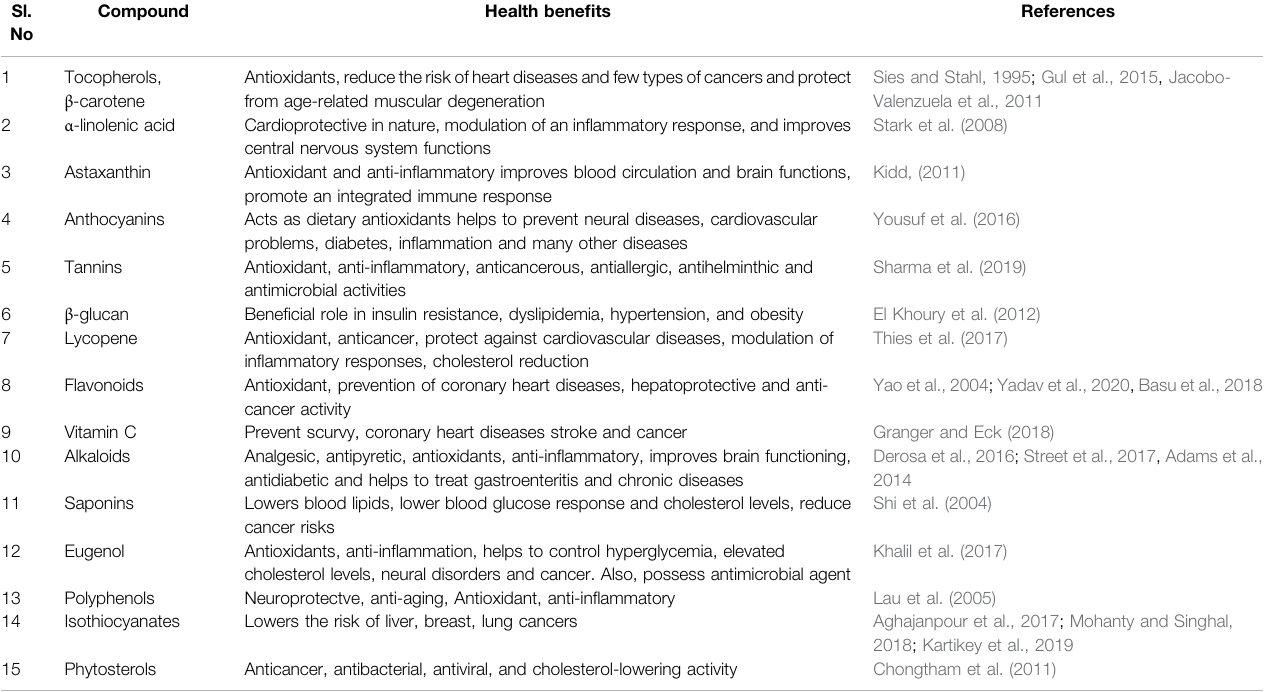
TABLE 1 | Functional compounds and their health bene fi ts. Sl.